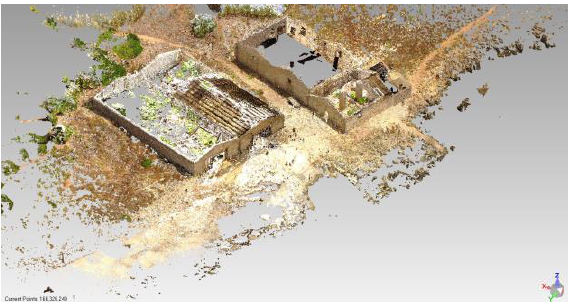
Figure 8. Point cloud model of the tonnara buildings on Capo Passero Island.